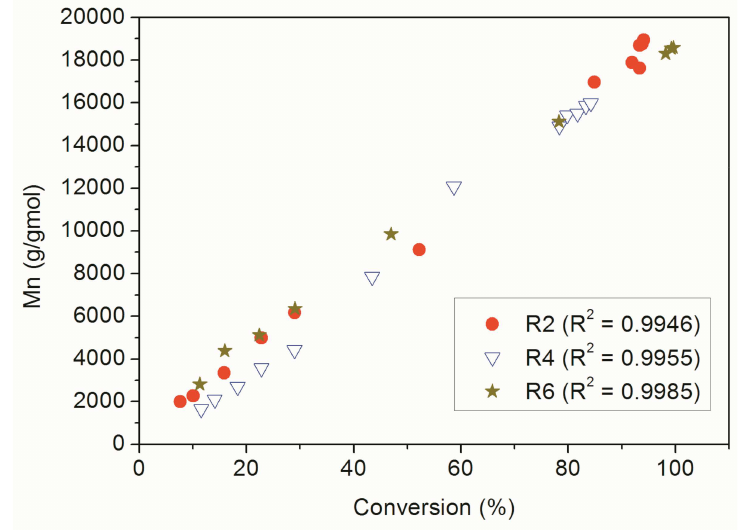
Figure 9. Dynamic evolution of Mn and monomer conversion for RAFT reactions.